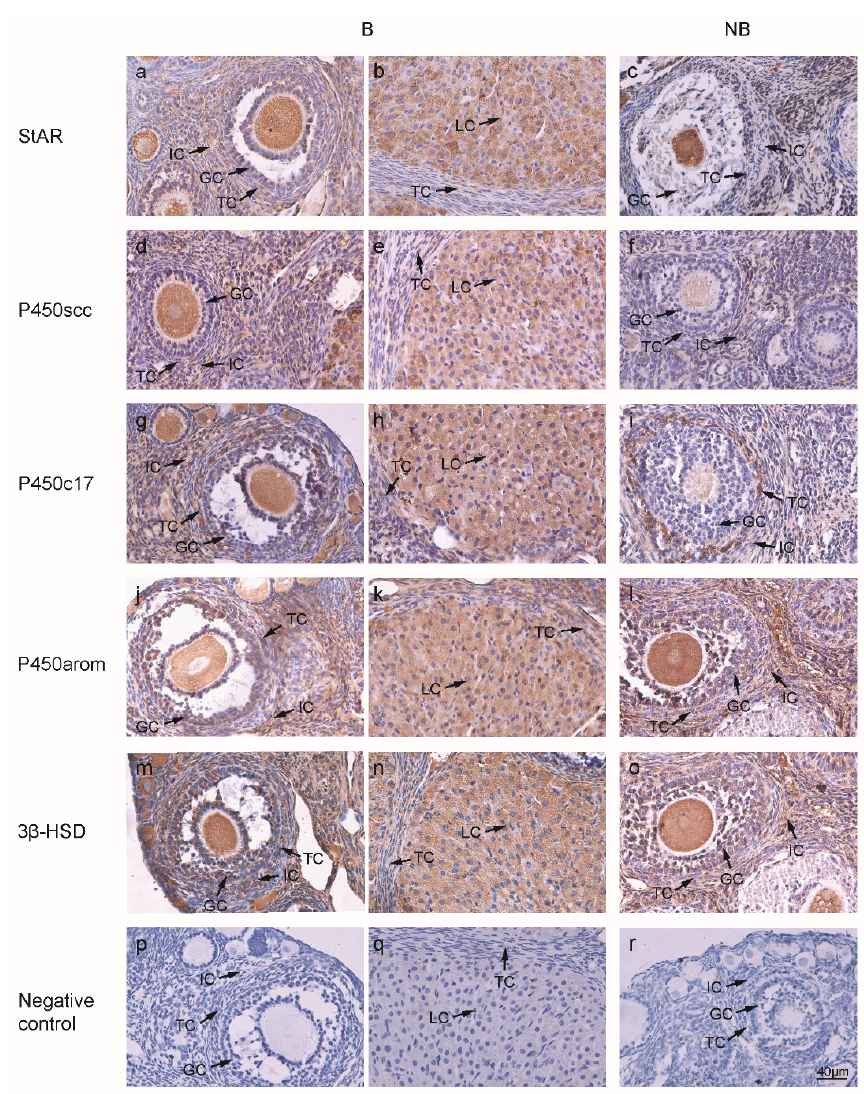
Figure 4. Immunolocalizations of StAR ( a – c ), P450scc ( d – f ), P450c17 ( g - i ), P450arom ( j – l ), and 3 β -HSD ( m – o ) during the breeding ( first two columns ) and non-breeding seasons ( third column ). Negative control of two periods represented in the last row ( p – r ). Abbreviations: B represents the breeding season; NB represents the non-breeding season; GC represents granulosa cells; TC indicates theca cells; IC indicates interstitial cells; LC represents luteal cells. Bar, 40 μ m. Table 3. Relative abundance of target proteins of StAR, P450scc, P450c17, P450arom, and 3 β -HSD in the ovaries of wild ground squirrels during the breeding and non-breeding